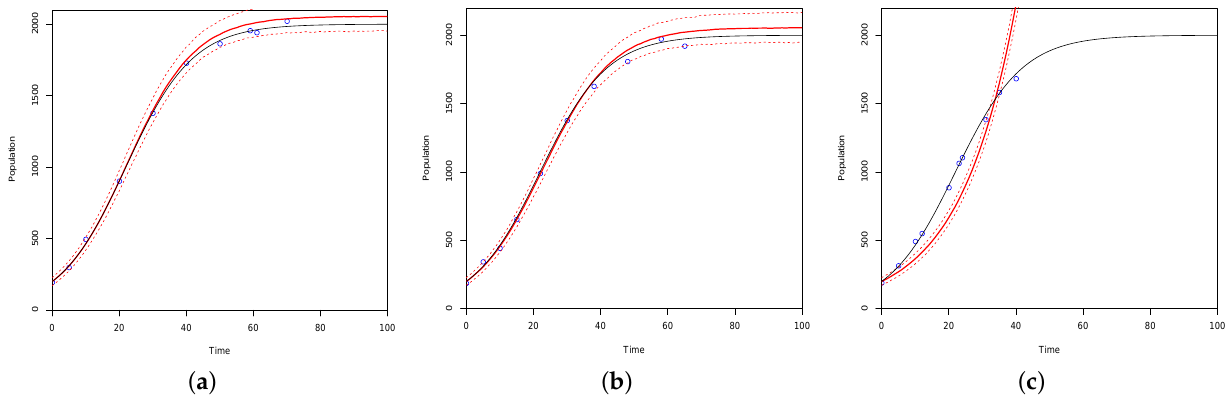
Figure 8. 10,000 MCMC samples are used in this simulation of a normal growth curve increasing at a 10% rate across 100 time points with a carrying capacity of 2000. Sequential optimality is used to find the ten best points for ( a ) I, ( b ) A Φ and ( c ) D Φ optimal designs. The optimal points are plotted in blue and fit with a solid red curve. The red dotted lines represent the 2.5% and 97.5% quantiles of the predicted values of the model. The black curve represents the ground truth